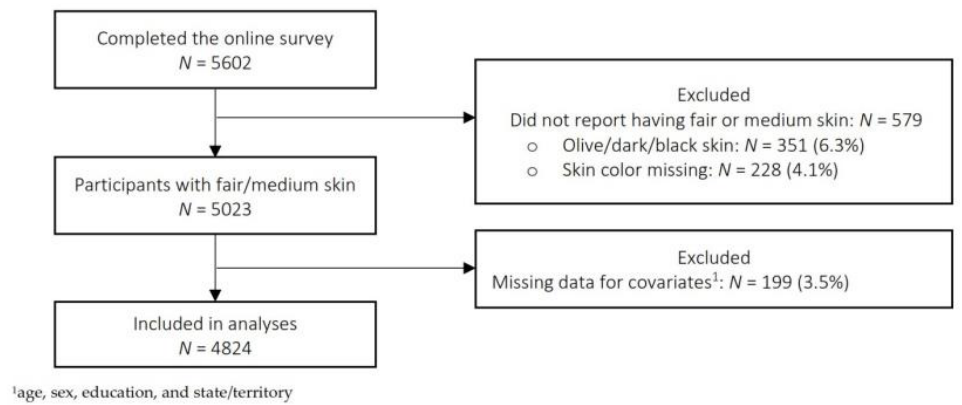
Figure 1. Flowchart of participant selection for analysis. Participant characteristics are described in Table 2. Just over half the participants were aged 60 years or older, 68% were women and 60% had a university degree. Nearly three quarters described their natural skin color on areas rarely exposed to the sun as “fair” and 58% had skin that would be moderately or badly burnt if exposed to the sun for 30 min without any protection. Forty-two percent reported a history of skin cancer